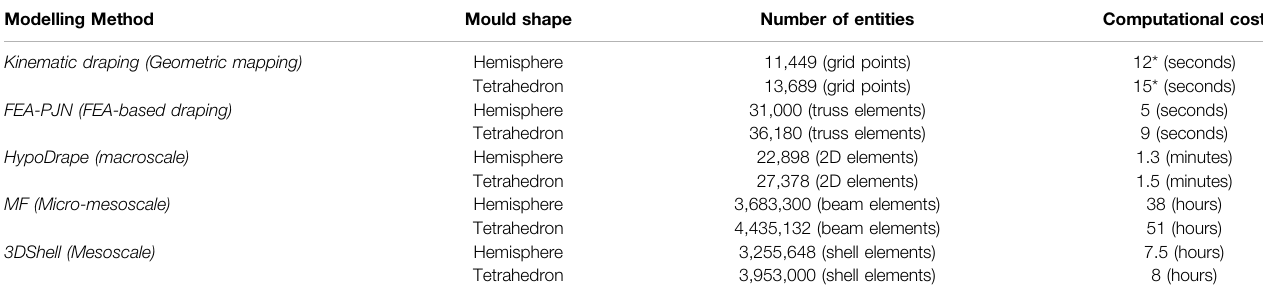
TABLE 5 | Summary of number of entities of all preform models (tooling parts are excluded) and computational cost of all simulations. *The kinematic draping models were solved using Python on a desktop workstation with single processor at 3.60 GHz. Modelling Method Mould